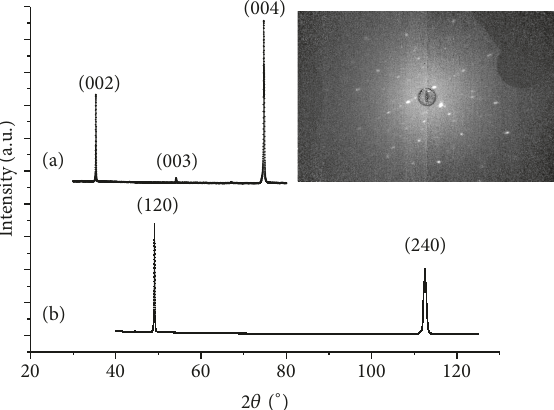
Figure 4: XRD patterns obtained from planes perpendicular (a) and parallel (b) to the growth direction of the EuBaCo 1.9 O 6−𝛿 single crystal.InsetshowstheLauegramtakenperpendiculartothegrowth direction of the